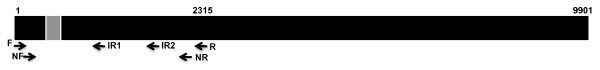
Diagrammatic representation of primers location on pvrbp-2 gene. Gray and black boxes indicate intron and exon respectively, and arrows indicate location of primers. F and R: forward and reverse primers of primary PCR respectively, NF and NR: forward and reverse primers of nested PCR respectively. IR1 and IR2 are internal sequencing primers.